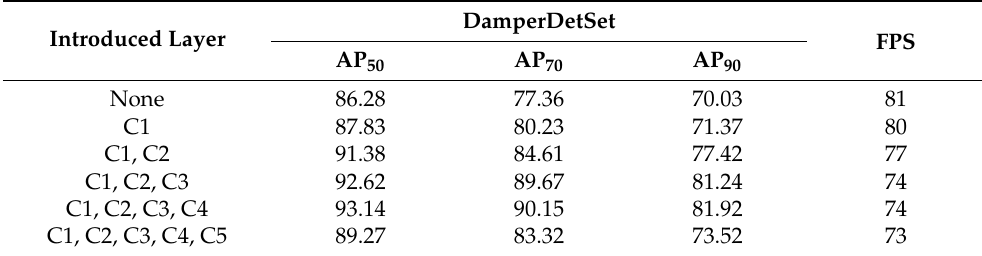
Table 5. APs of different introduction times of the attention